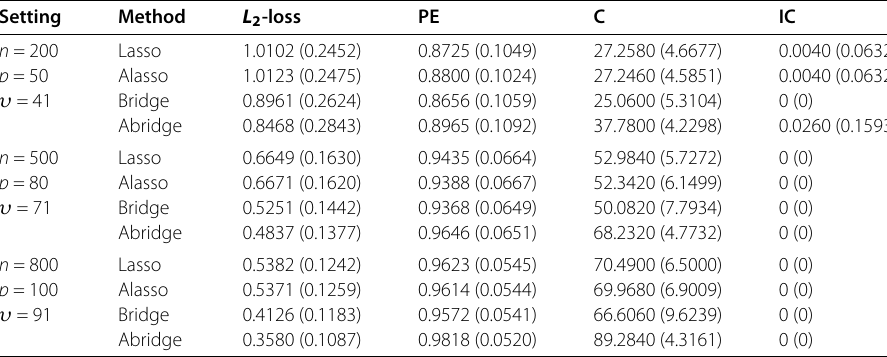
Table 2 Simulation results for ρ =